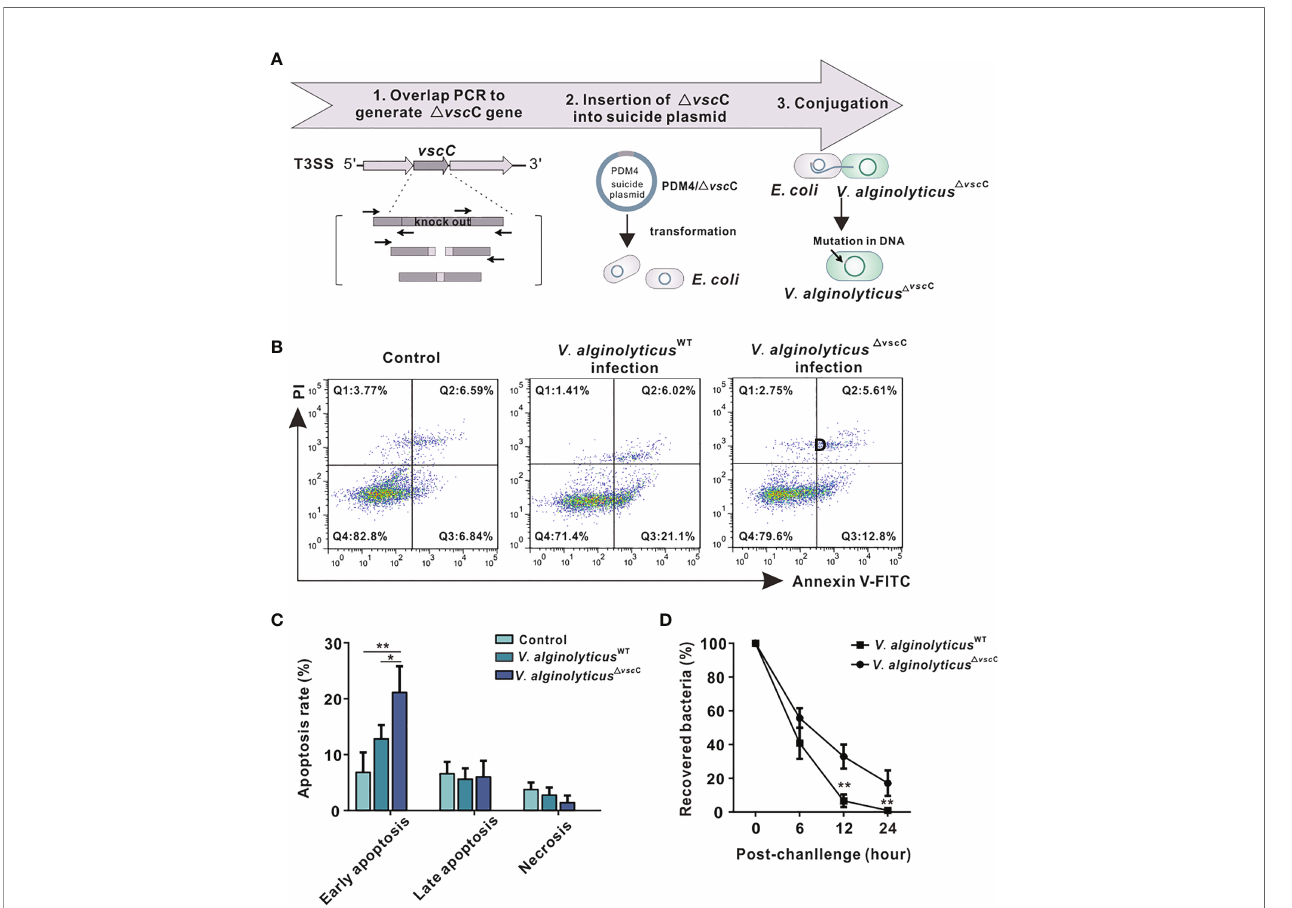
FIGURE 1 | Effects of challenges by differentially virulent V. alginolyticus strains on host immune cells. (A) Work fl ow of the construction of attenuated alginolyticus △ vscC strain. A vscC -deletion fragment was made by overlap PCR to insert it in the suicide vector pDM4, generating pDM4/ △ vscC . E.coli strains (SY327 and S-17) were respectively transformed with the recombinant suicide plasmid. Subsequently, conjugative transfer with V. alginolyticus WT was performed to obtain the mutant V. alginolyticus △ vscC strain. (B) Representative fl ow cytometry results for apoptosis of C. hongkongensis hemocytes following double staining with annexin V- fl uorescein isothiocyanate and propidium iodide. Q1: Cells stained as PI positive only (upper left quadrant) were necrotic/non-viable cells. Q2: Cells stained doubly positive by annexin V-FITC and PI (top right quadrant) were cells undergoing late apoptosis. Q3: On the lower right quadrant were cells stained as annexin V-FITC positive only, corresponding to cells undergoing early apoptosis. Q4: The lower left quadrant (PI and annexin V negative cells) shows living cell population. (C) Statistical analysis of wild-type strain and attenuated strain-induced apoptosis, including early apoptosis, late apoptosis, and necrosis. Data were analyzed in GraphPad 8.0 by two-way ANOVA and presented as mean ± SEM (n = 3). Statistical signi fi cance was determined at * p < 0.05 and ** p < 0.01. (D) Bacterial clearance of oyster hemocytes following V. alginolyticus WT and V. alginolyticus △ vscC injections (injected with a concentration of 10 9 CFU/ml). The x -axis displays time lapsed post-injection, and the y -axis shows bacterial clearance ef fi ciency (recovered bacteria). Data were analyzed in GraphPad 8.0 by two-way ANOVA (n = 3). Statistical signi fi cance was determined at * p < 0.05 and ** p <